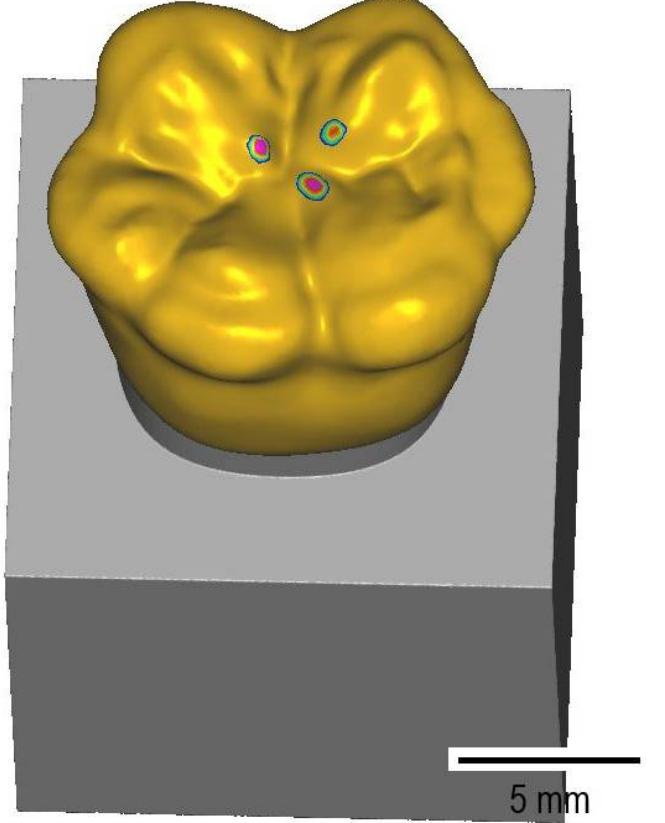
Figure 3. STL-file of the crown with retention geometries and a generated three-point contact in the central fissure for the antagonist metal stylus.